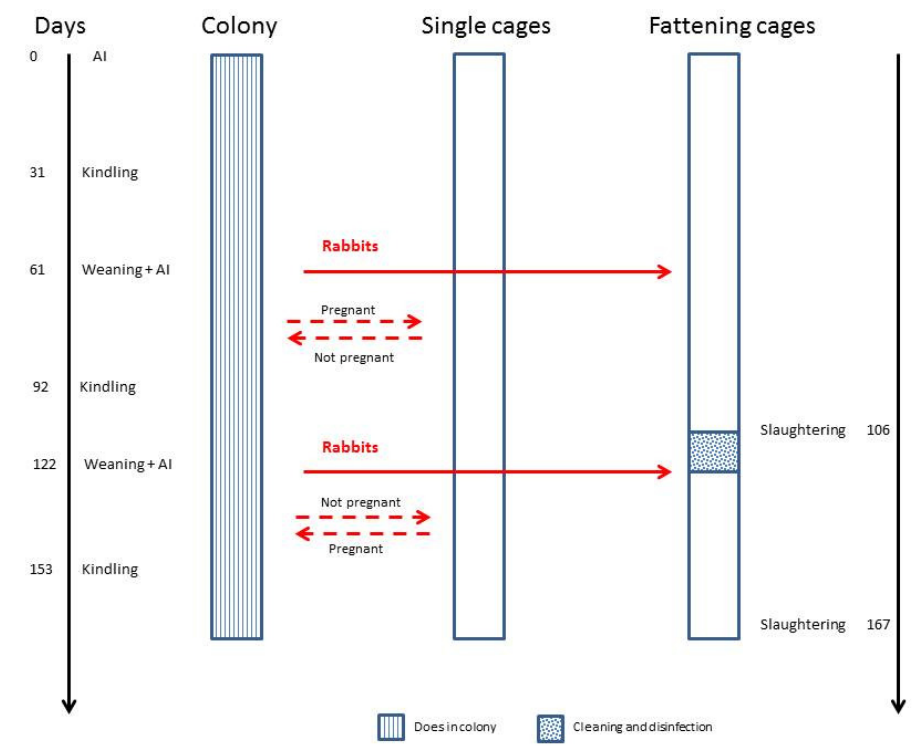
Figure 3. Scheme of rabbit production protocol of C1 cages. The production cycle is open and requires “external” cages for replacing the non-pregnant does and for housing the weaned rabbits until slaughtering.